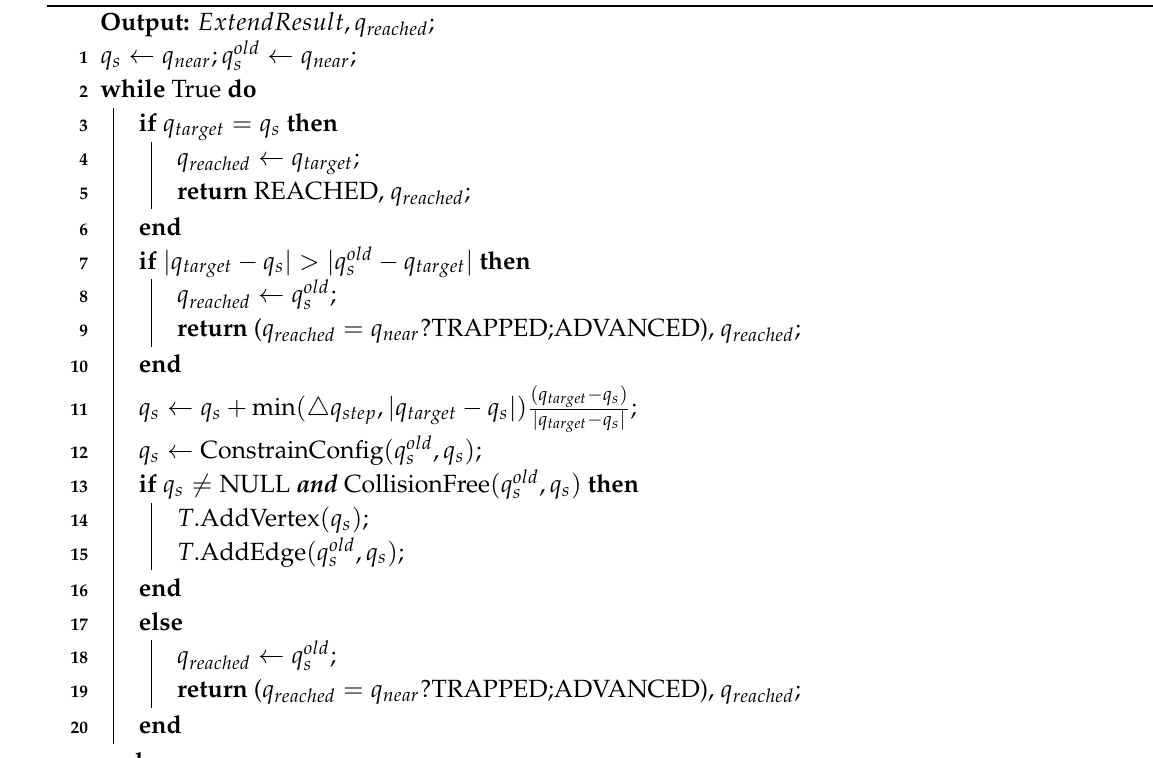
Algorithm 4: ConstrainedExtend( T , q near , q target